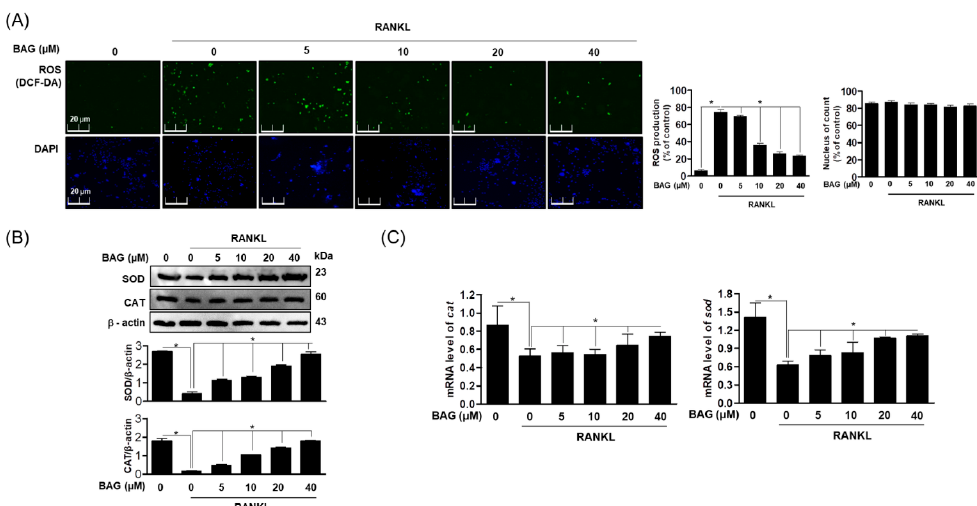
Figure 3. Inhibitory Effect of BAG on RANKL induced osteoclast of functions. ( A ) RAW264.7 cells (5 × 10 3 ) were seeded, then RANKL (50 ng/mL) with or without the indicated concentration of BAG (5–40 mM) was placed in the osteo-surface well for 5 days. The percentage of bone resorption pit area relative to the total osteo-surface well area was quantified for the experimental condition. RAW 264.7 cells were cultured in the RANKL with or without BAG for 1, 3, and 5 days to induce osteoclast differentiation, and the protein expression of integrin β 3 was measured by Western blot ( B ), and the levels of CCL4 mRNA were measured by real-time PCR ( C ). The number of migrated cells with confluency average using Incucyte ® Live-Cell analysis imaging system ( D ). * p < 0.05, versus the RANKL-treated group.